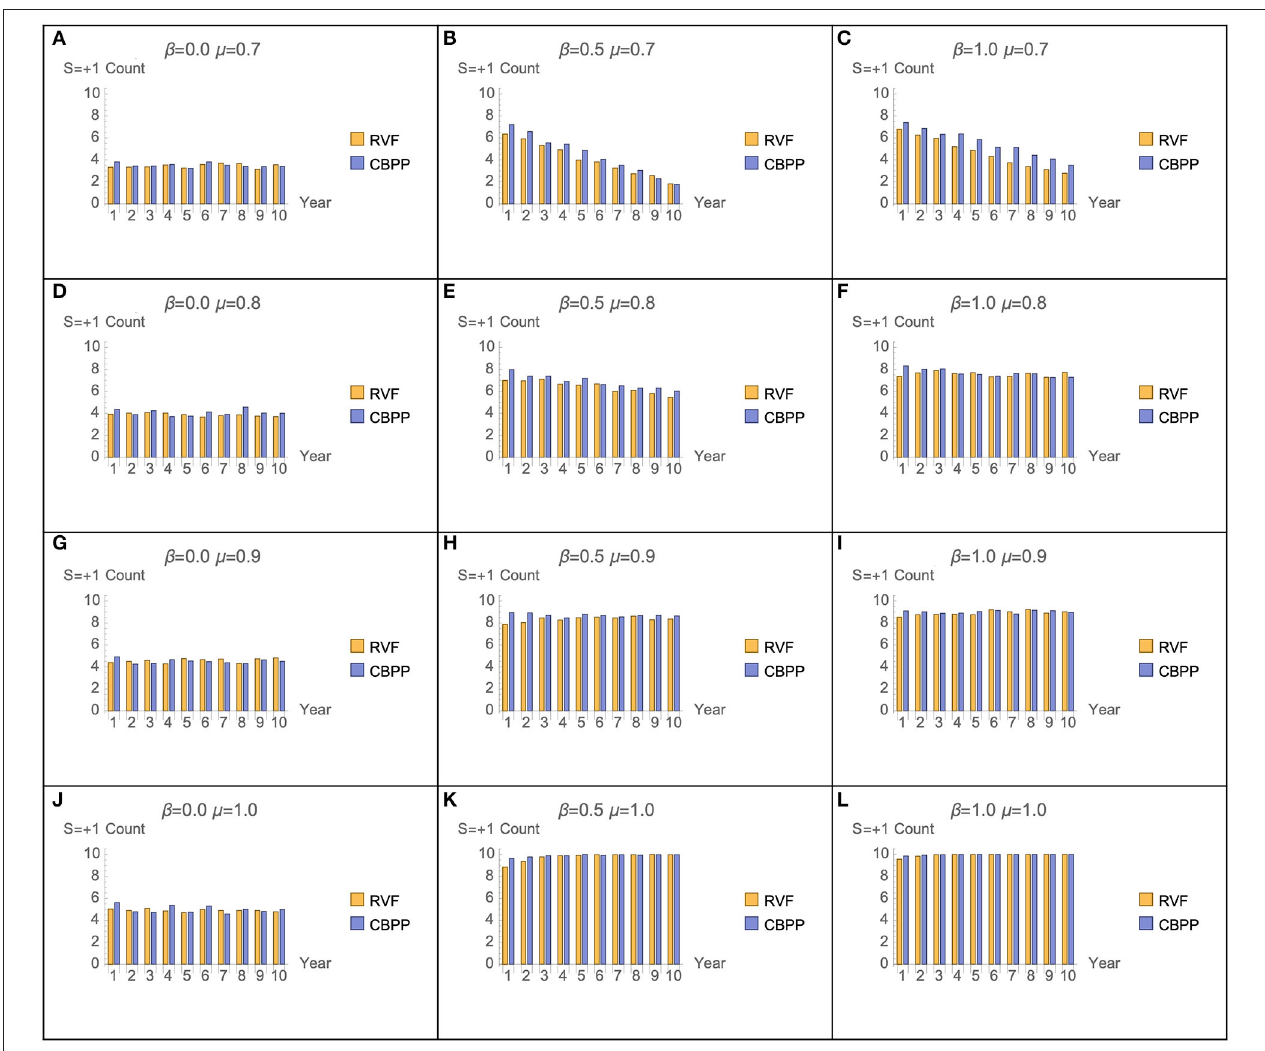
FIGURE 7 | Ratio of RVF and CBPP vaccination decisions for β and µ parameter combinations (50 seeds used per parameter